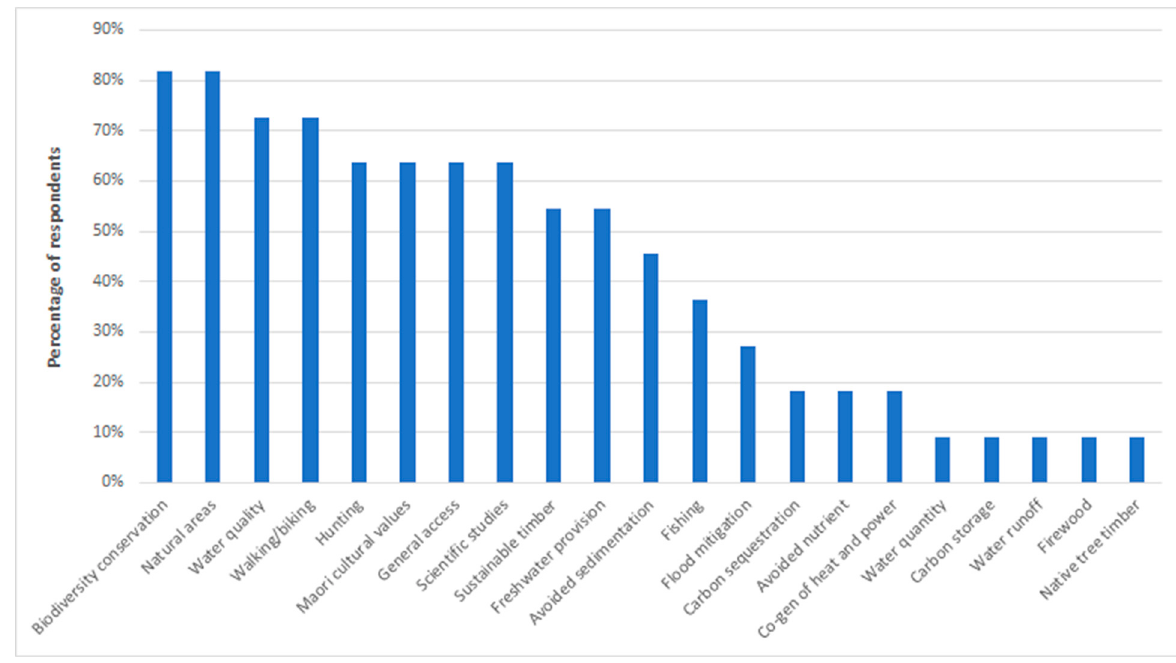
Figure 7. Ecosystem services considered important to social license to operate, sustainable forest management and forest certification by participating forest companies (n = 11).